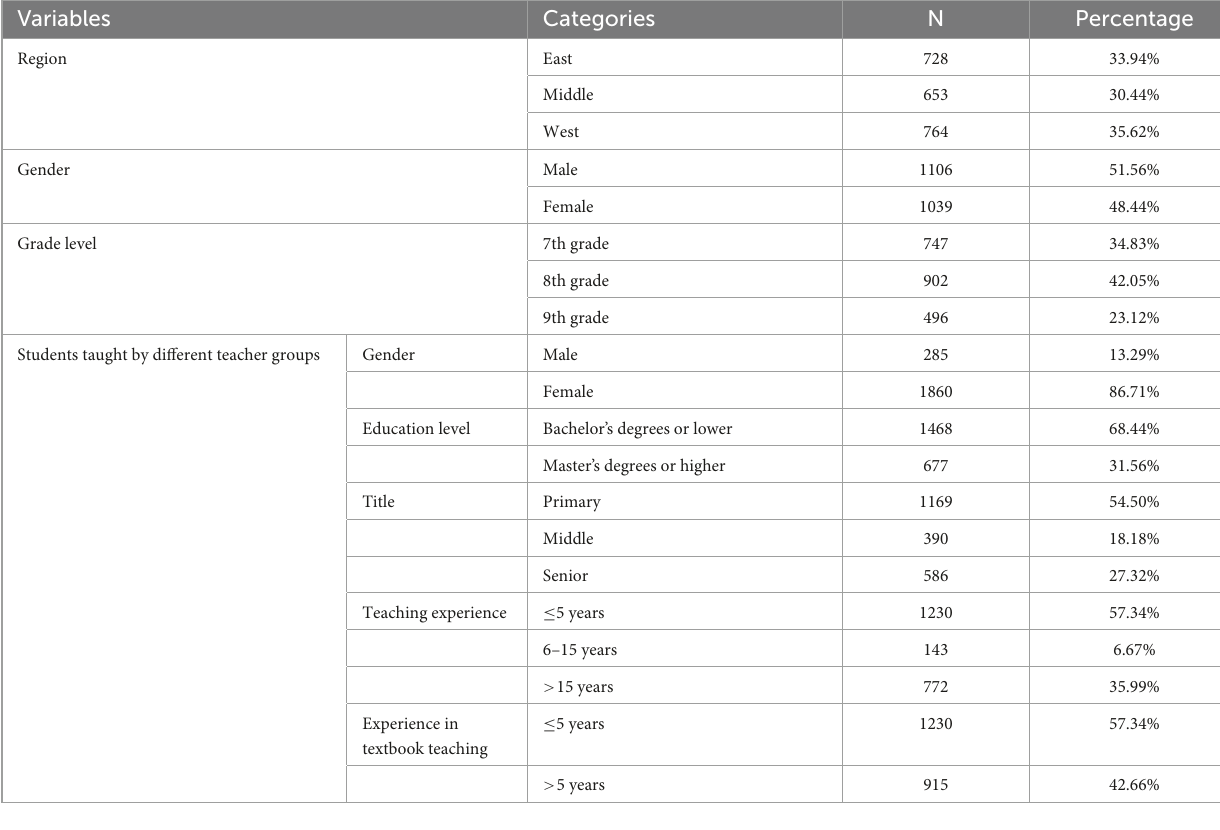
TABLE 2 The profiles of students surveyed.